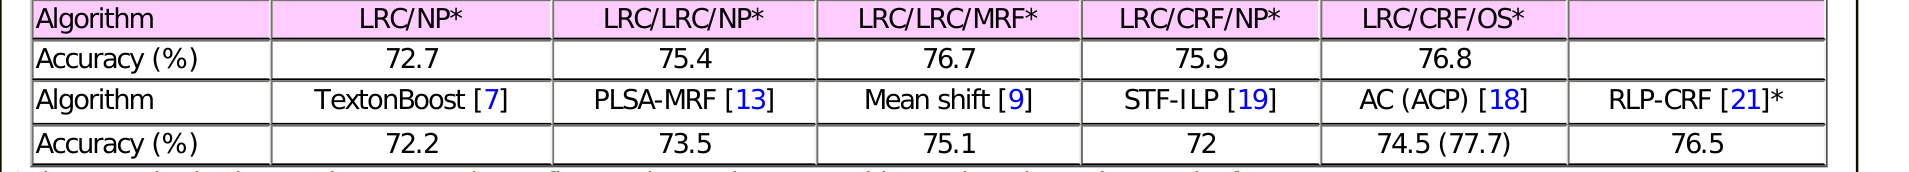
Table 1 Mean pixel level accuracies for various algorithms on